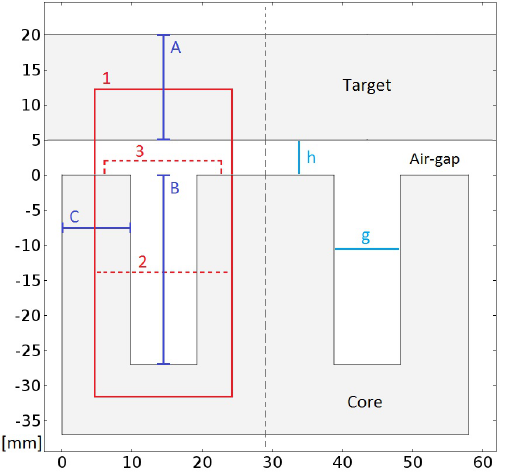
Figure 7. Schematic cross-section of one of the electromagnets. Main flux path is along Line 1. Line 2–3 are leakage flux paths. Important lengths are marked A–C, g–h. As can be seen, so are the electromagnet core types a double horseshoe (or